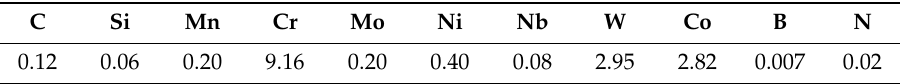
Table 1. Chemical compositions of 9%Cr turbine steel (wt %).